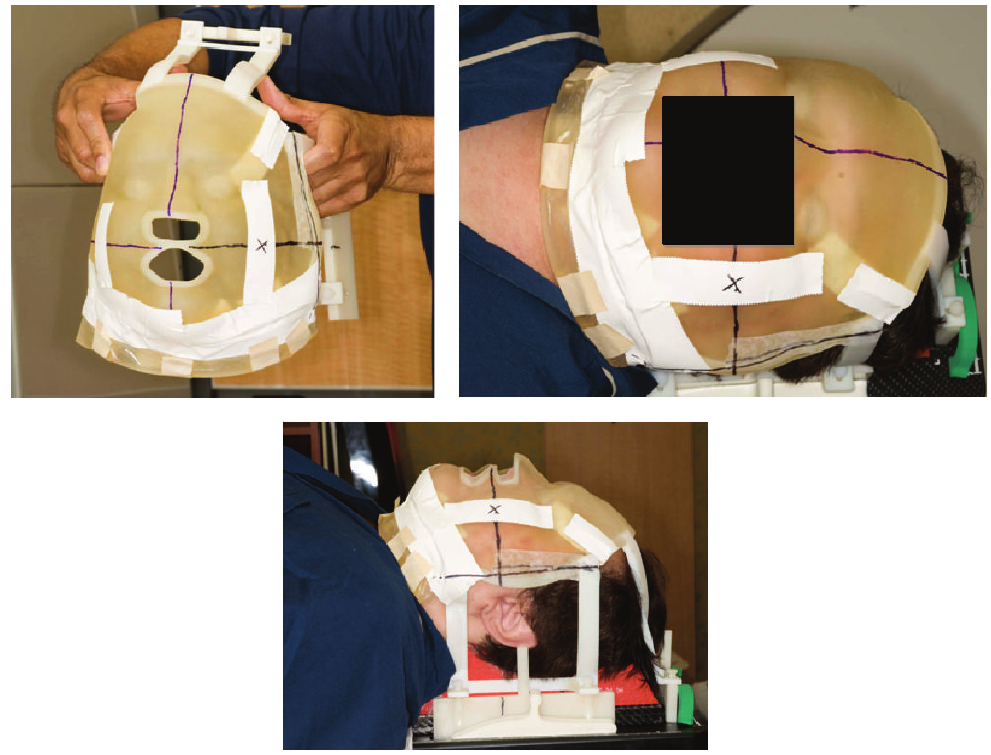
Figure 3: Final immobilization mold using customized bolus.